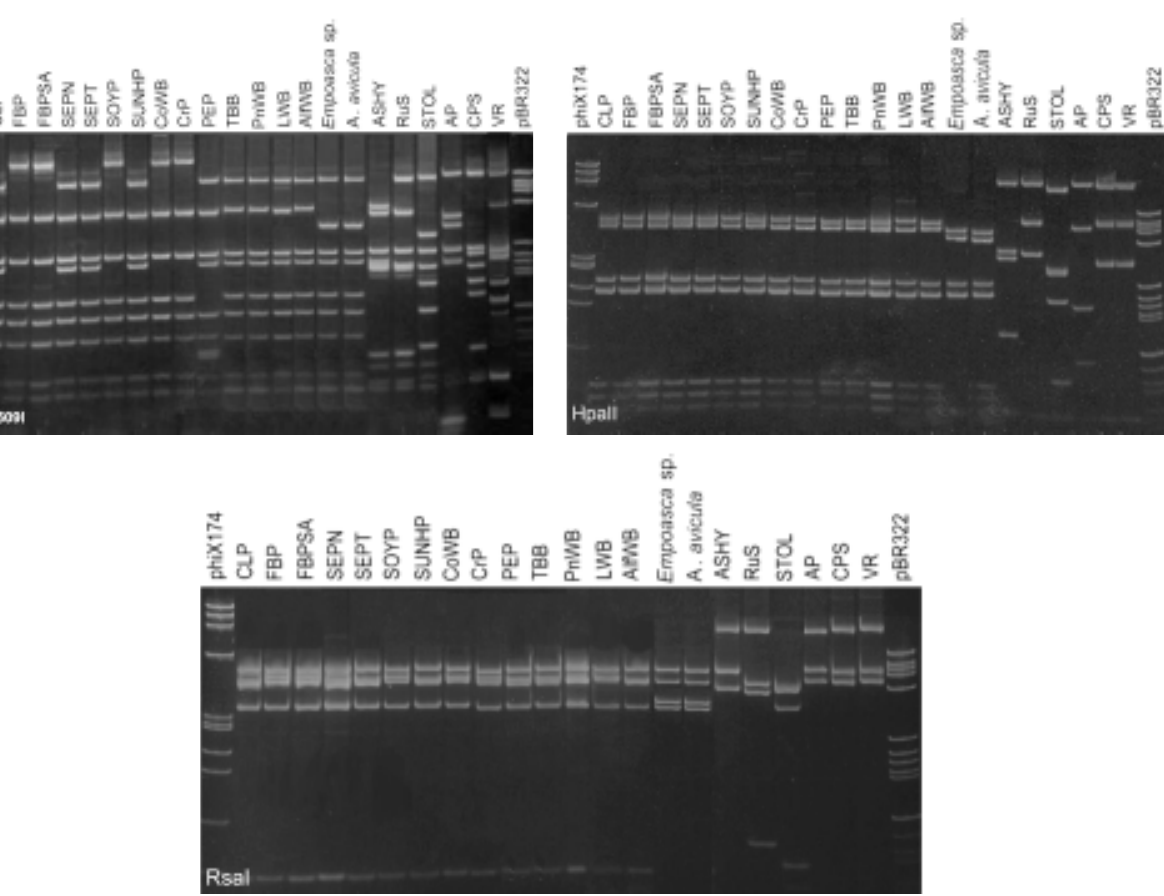
Fig. 2. Polyacrylamide gels (5%) showing the RFLP patterns of phytoplasmas detected in A. avicula and Empoasca sp., OmanAlfWB and 19 other phytoplasma strains of 16S plus spacer region DNA fragments amplified with P1/P7 primers analyzed with (A) Tsp509 I, (B) Hpa II and (C) Rsa I restriction enzymes. Markers pBR322 and Ψ X174 Hae I- II digested. Other abbreviations: AlfWB, alfalfa witches’ broom from Oman; CLP, cleome phyllody; FBP, faba bean phyllody; FBPSA, Crotalaria saltiana phyllody; SEPN, sesame phyllody; SEPT, sesame phyllody; SOYP, soybean phyllody; SUNHP, sun hemp witches’ broom; CoWB, cotton phyllody; CrP, phyllody from C . juncea ; PEP, Pichris echioides phyllody; TBB, tomato big bud from Australia; PnWB, peanut witches’ broom; LWB, lime witches’ broom; ASHY, ash yellows; RuS, rubus stunt; STOL, Stolbur; AP, apple proliferation; CPS, Catharanthus phyllody; VR, beet leafhopper transmitted